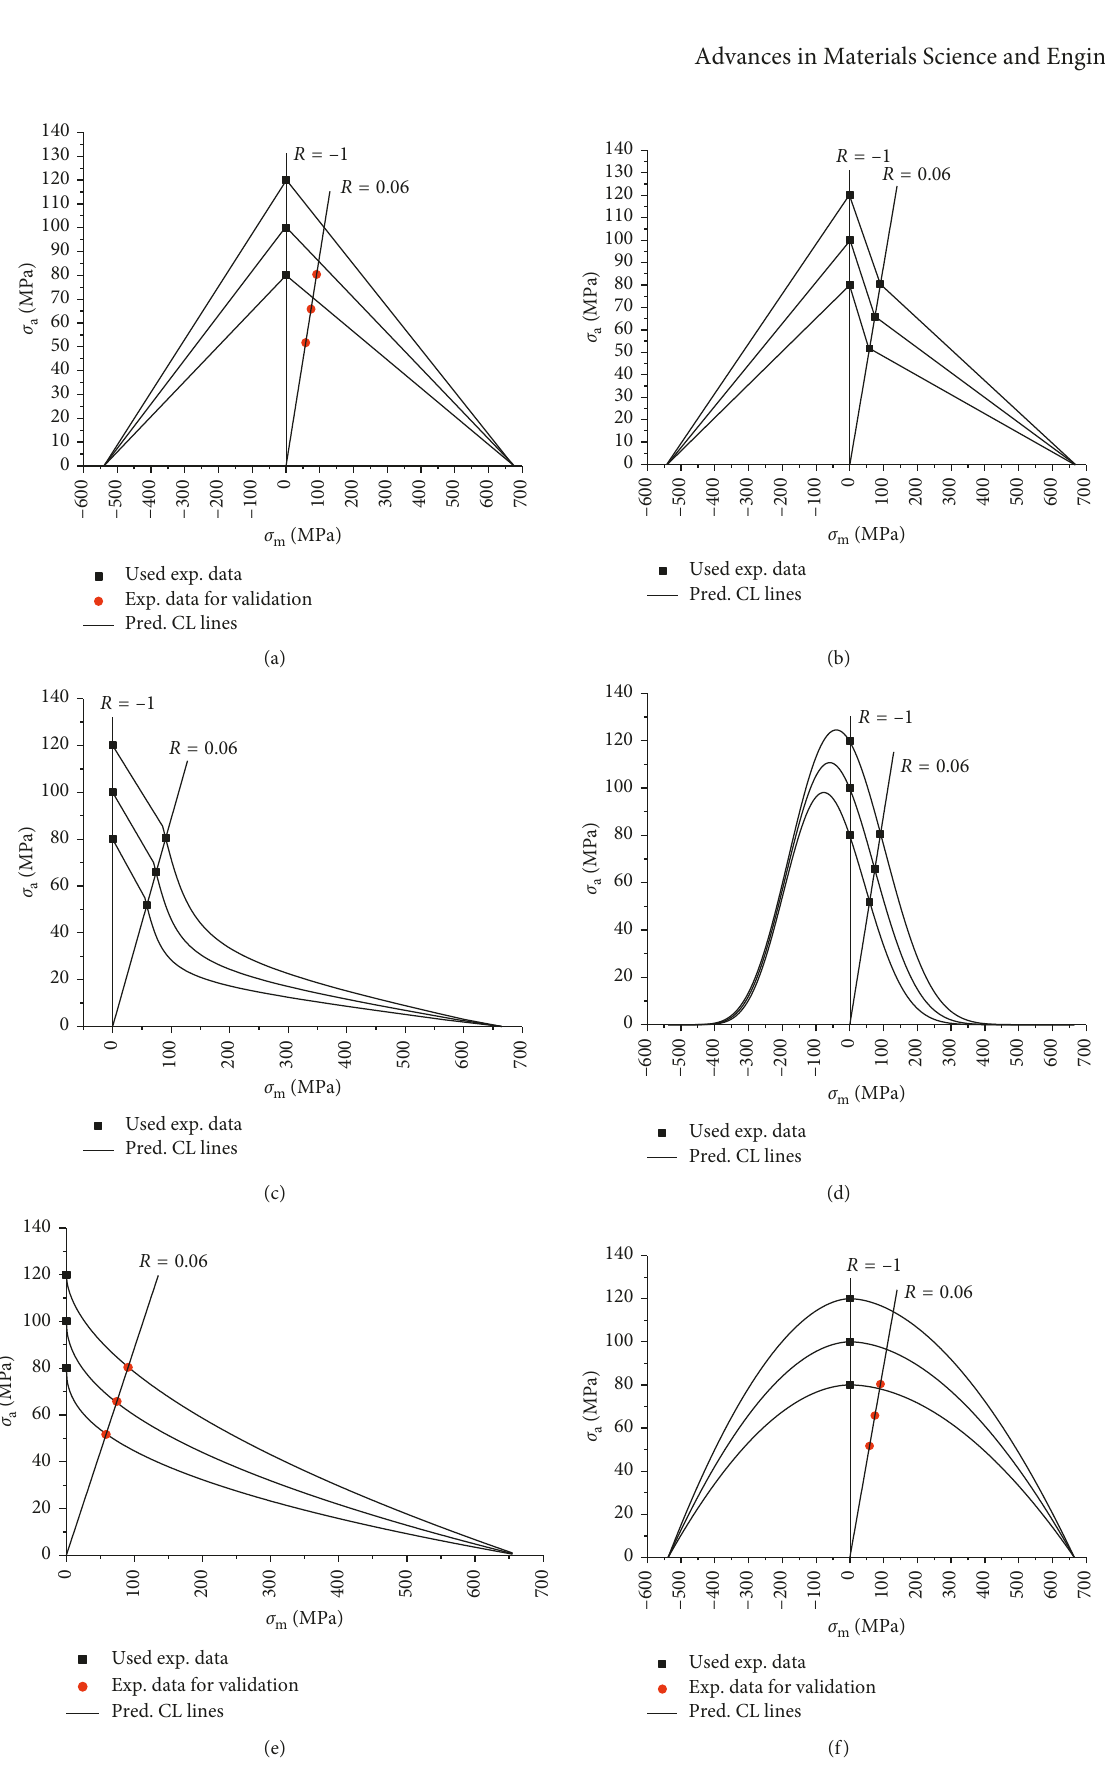
Figure 10: Constant life diagrams for N � 47643 , 110154 , and 307610 for 3/2 laminates: (a) Goodman; (b) piecewise linear; (c) piecewise nonlinear; (d) Bell; (e) Boerstra; (f)